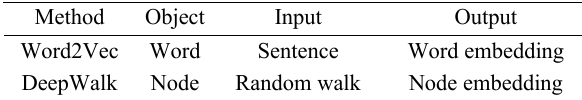
Table 1 Analogy between word2vec and